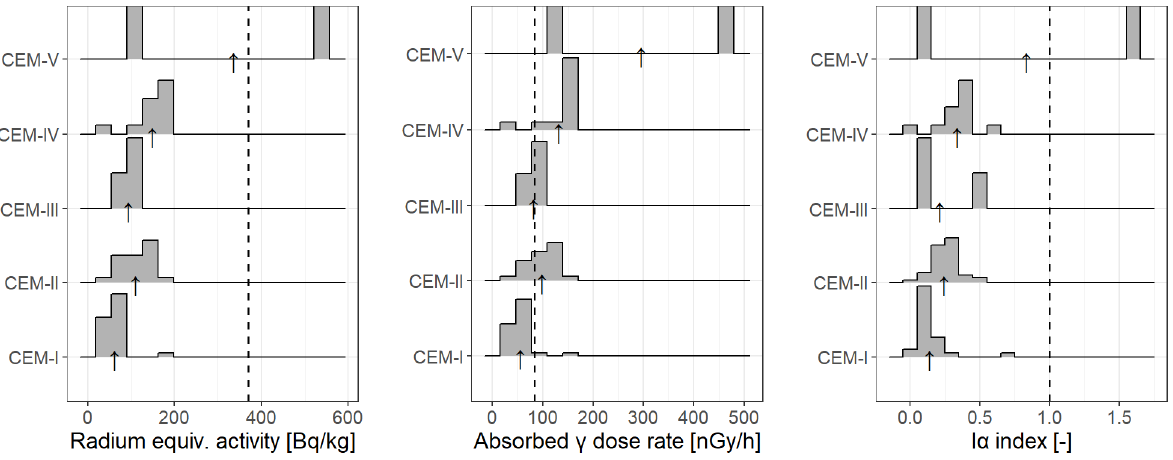
Figure 6. Histogram graphs for hazard indices Ra eq , D and I α for five types of cements, based on such data from Table 4, for which the authors provided information on the type of cement. The arrows indicate the weighted averages within the group.